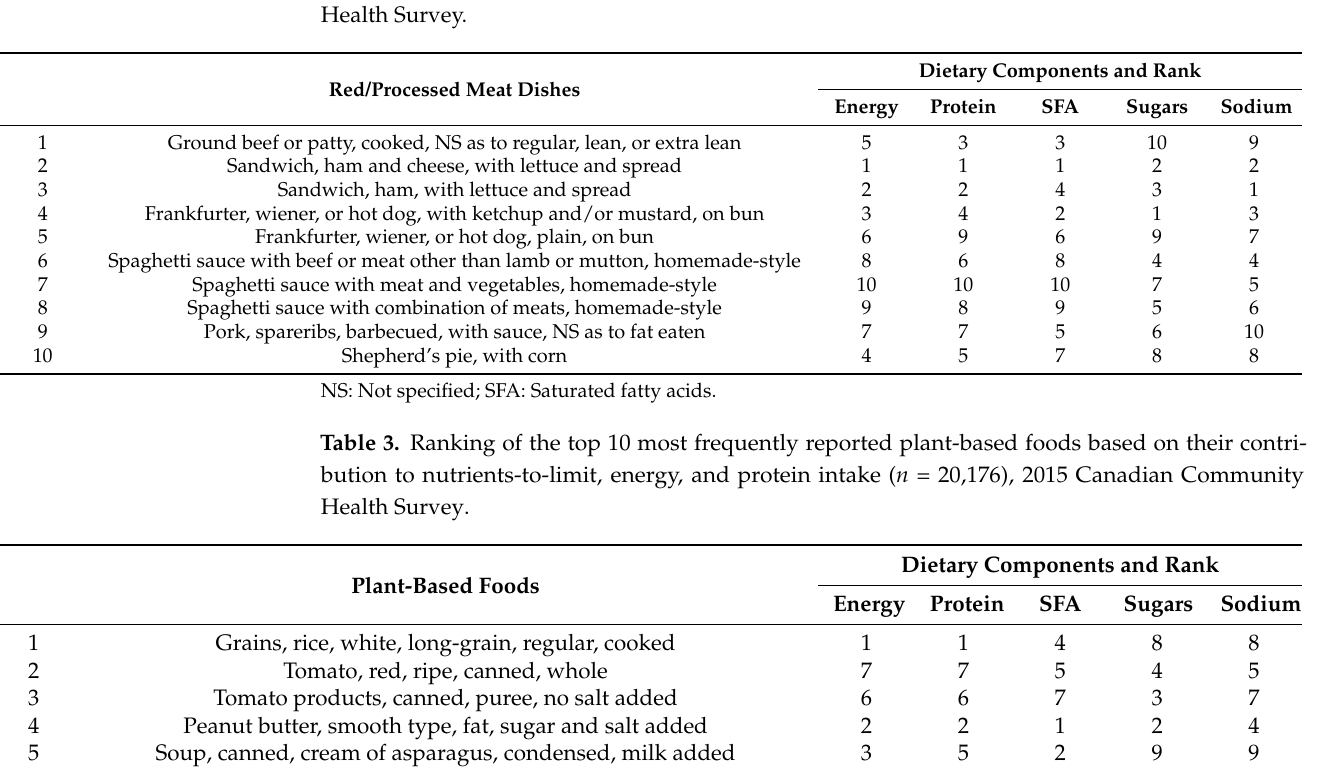
Table 2. Ranking of the top 10 most frequently reported red/processed meat dishes based on their contribution to nutrients-to-limit, energy, and protein intake ( n = 20,176), 2015 Canadian Community Health Survey.